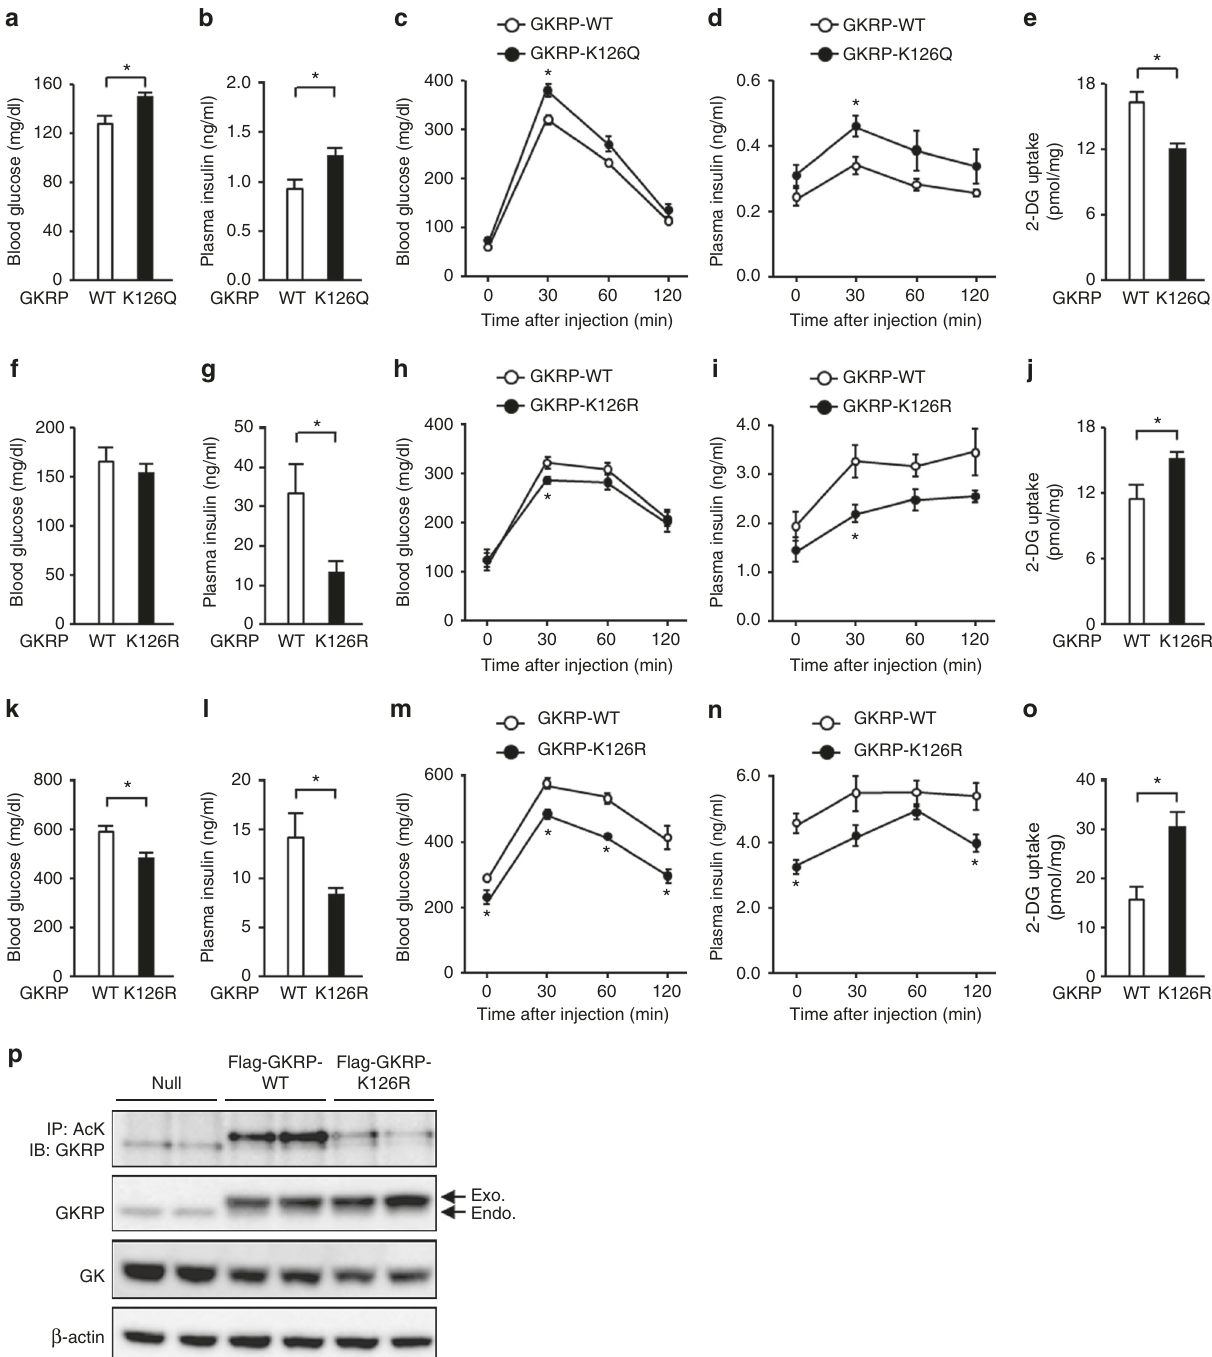
Fig. 7 Deacetylation of K126 on GKRP improves hepatic glucose uptake and glucose intolerance in diabetic obese mice. a – e Effect of adenovirus-mediated hepatic overexpression of GKRP-K126Q or GKRP-wild-type (GKRP-WT) on blood glucose ( a ) and plasma insulin ( b ) levels under free-feeding conditions and changes in blood glucose ( c ), plasma insulin ( d ), and hepatic 2-deoxyglucose (2-DG) uptake ( e ) levels during glucose administration (2 g/kg) in lean mice ( n = 5). f – j Effect of adenovirus-mediated hepatic overexpression of GKRP-K126R or GKRP-WT on blood glucose ( f ) and plasma insulin ( g ) levels under free-feeding conditions and changes in blood glucose ( h ), plasma insulin ( i ), and hepatic 2-DG uptake ( j ) levels after glucose administration (1 g/kg) in HFD mice ( n = 5). k – o Effect of adenovirus-mediated hepatic overexpression of GKRP-K126R or GKRP-WT on blood glucose ( k ) and plasma insulin ( l ) levels under free-feeding conditions and changes in blood glucose ( m ), plasma insulin ( n ), and hepatic 2-DG uptake ( o ) levels after glucose administration (1 g/kg) in db/db mice ( n = 4). p Acetylation level of GKRP in db/db mice transfected with adenovirus encoding Flag-GKRP-WT or Flag-GKRP-K126R. Endo. endogenous GKRP, Exo. exogenous GKRP. * P < 0.05; Student ’ s t -test ( a – o ). Data in p are representative of at least three independent experiments. Error bars show